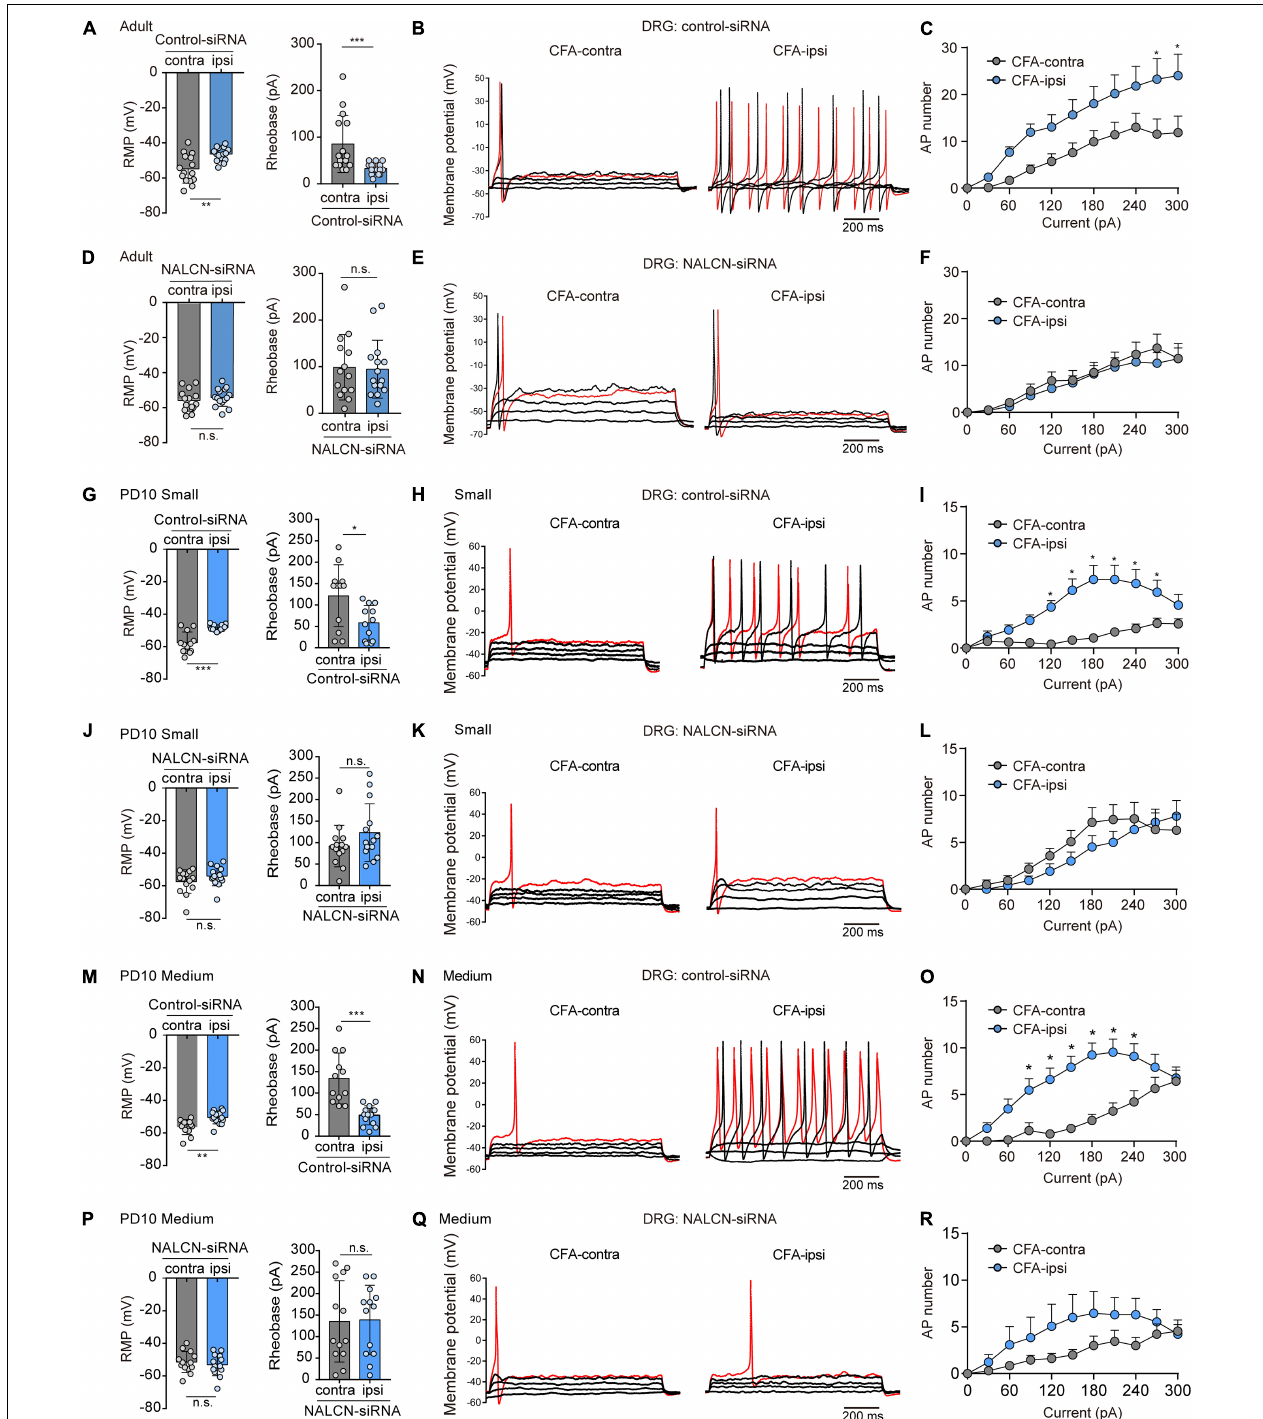
FIGURE 5 | Sodium leak channel enhances the excitability of small- and medium-sized DRG neurons after CFA injection in adult and neonatal rats. (A,D) Excitability of small and medium neurons in DRG compared between CFA-contralateral and CFA-ipsilateral sides based on RMP and rheobase from the rats that received control-siRNA and/or NALCN-siRNA combined with injection of CFA in adult rats ( n = 14–15, unpaired t -test). (B,E) Representative traces of action potentials in the DRG neurons in control-siRNA and/or NALCN siRNA-treated rats. Red traces were the action potentials when receiving the same current injection. (C,F) Numbers of APs were increased more in small and medium DRG neurons of CFA-ipsi side than those of CFA-contra side from control siRNA-treated rats [ (C) , n = 14, by two-way ANOVA, Holm–Sidak test], but no difference was shown between CFA-ipsi side and CFA-contra side from the NALCN-siRNA-treated rats [ (F) , n = 15, by